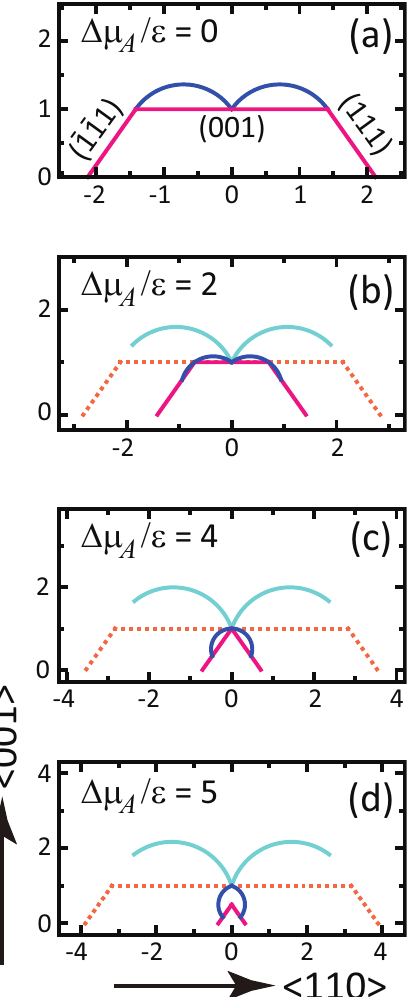
Figure 6. Cross-section of the polar graph of surface tension (Wulff figure) and the ECS at temperature T = 0 K. ∆ µ A / (cid:101) = ( a ) 0, ( b ) 2.0, ( c ) 4.0, and ( d ) 5.0. Dark blue lines: surface tension for the vicinal surface with A steps, where the step edge of an A step is covered by A atoms. Light blue lines: surface tension with B steps. Solid red lines: ECS for the vicinal surface with A steps. Dotted lines: ECS for the vicinal surface with B steps. For ∆ µ A / (cid:101) > 4, the (001) terrace surface is covered by A atoms. ∆ µ A = − ∆ µ B